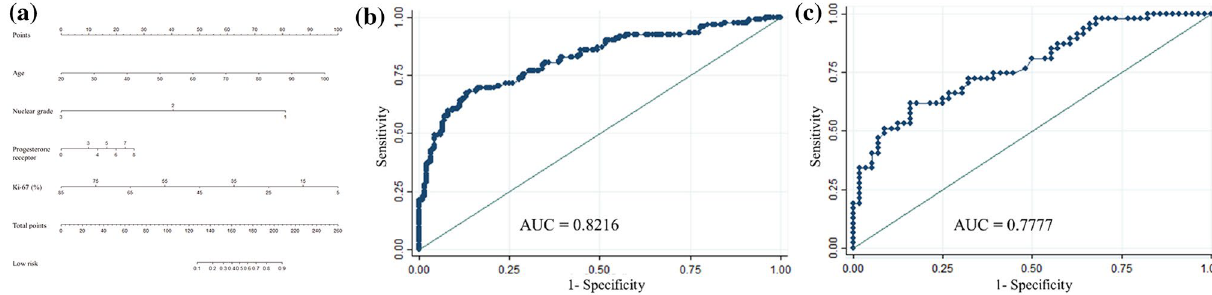
Fig. 1 a Nomogram to predict low-risk recurrence score of MammaPrint result and receiver operating characteristic curve of nomogram. b Training group of 306 patients. c Validation group of 103 patients